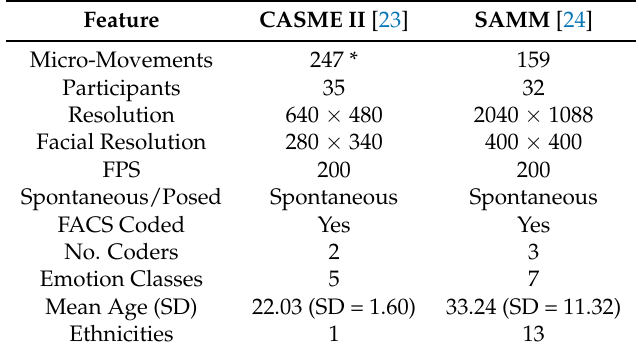
Table 1. A summary of the different features of the CASME II and SAMM